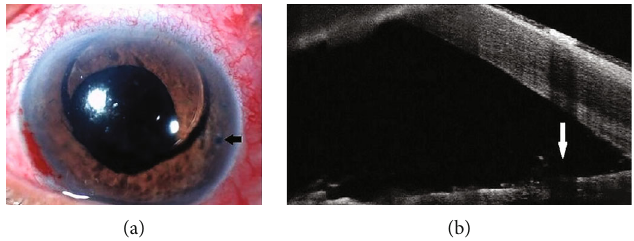
Figure 2: (a) Anterior segment photograph of the left eye showing seeping of silicone oil into the anterior chamber following laser peripheral iridotomy (black arrow). (b) Anterior segment optical coherence tomography of the left eye showing the release of iridocorneal apposition and widening of the angle following laser peripheral iridotomy (white